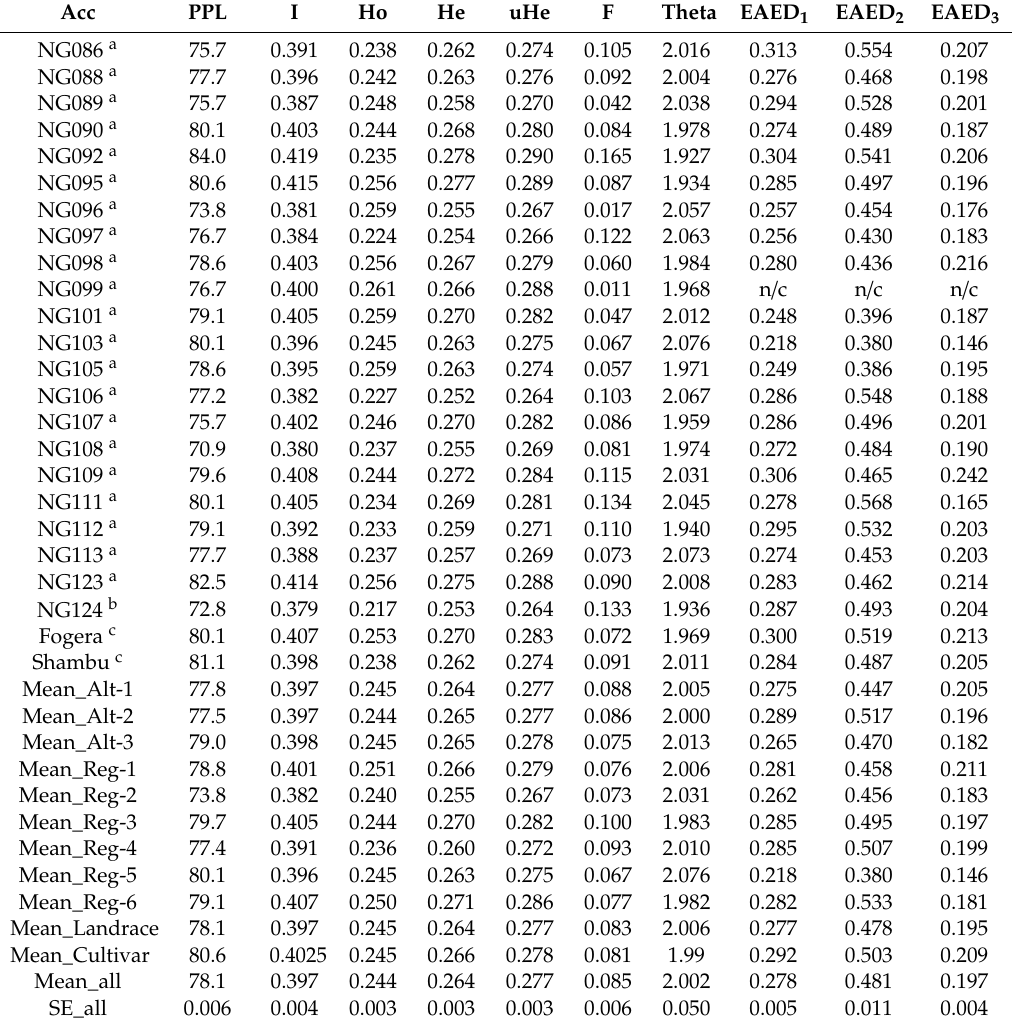
Table 2. Summary of genetic diversity estimates for 24 noug accessions based on 202 single-nucleotide polymorphic (SNP) loci or its subsets, and mean values for di ff erent groups and all